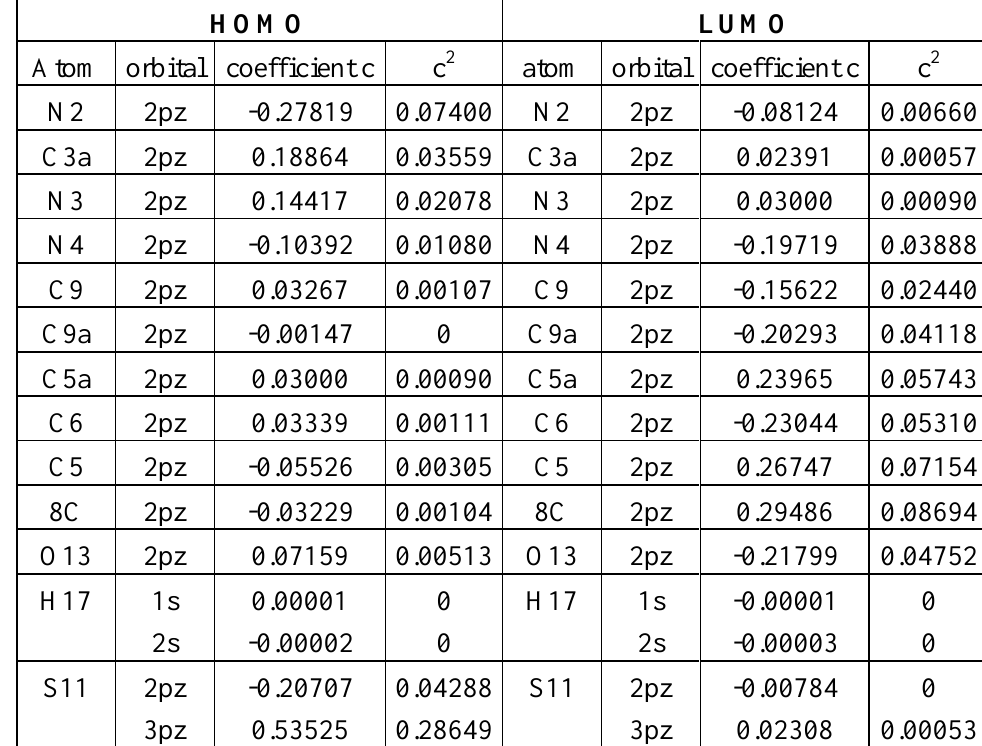
Table 1 . The molecular orbital coefficients of the anion form of 1 .